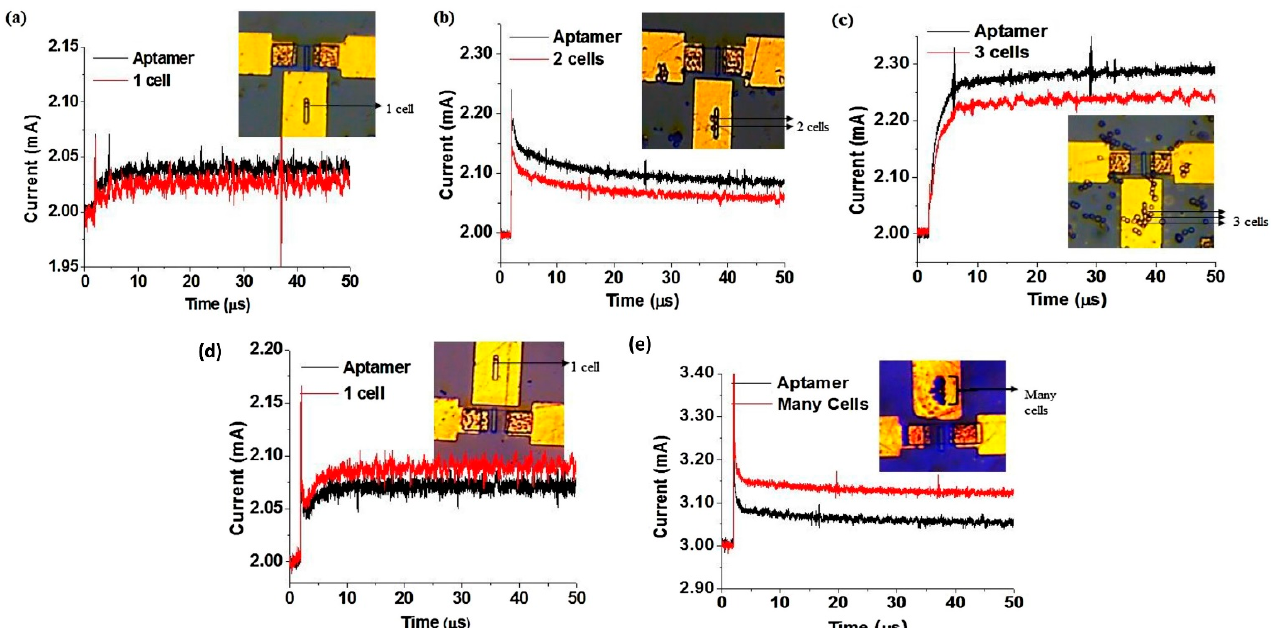
Figure 8. Change in drain current gain upon aptamer immobilization tested in 1 X PBS ( a ) 1 cell ( b ) 2 cells ( c ) 3 cells. Change in drain current in cell culture medium ( d ) 1 cell and ( e ) many cells captured by the aptamer. Reproduced with permission from reference [145]. Copyright 2018,